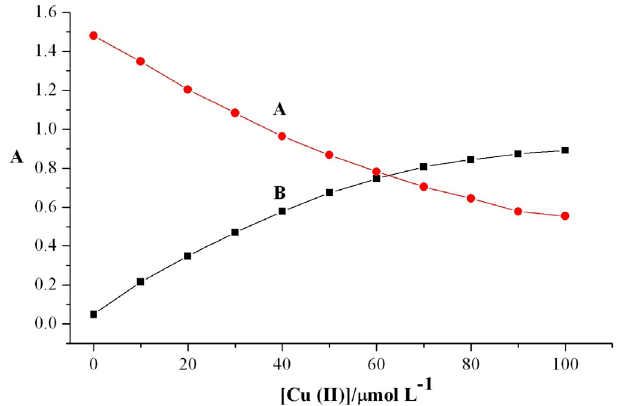
FIGURE 7 - Effect of Cu(II) on the absorbance of maximum absorbance of ( A ) 1x10 -4 mol L -1 indigo carmine solution in 0.1 mol L -1 carbonate buffer solution at pH 10 ( l = 615 nm) and ( B ) the complex at 715